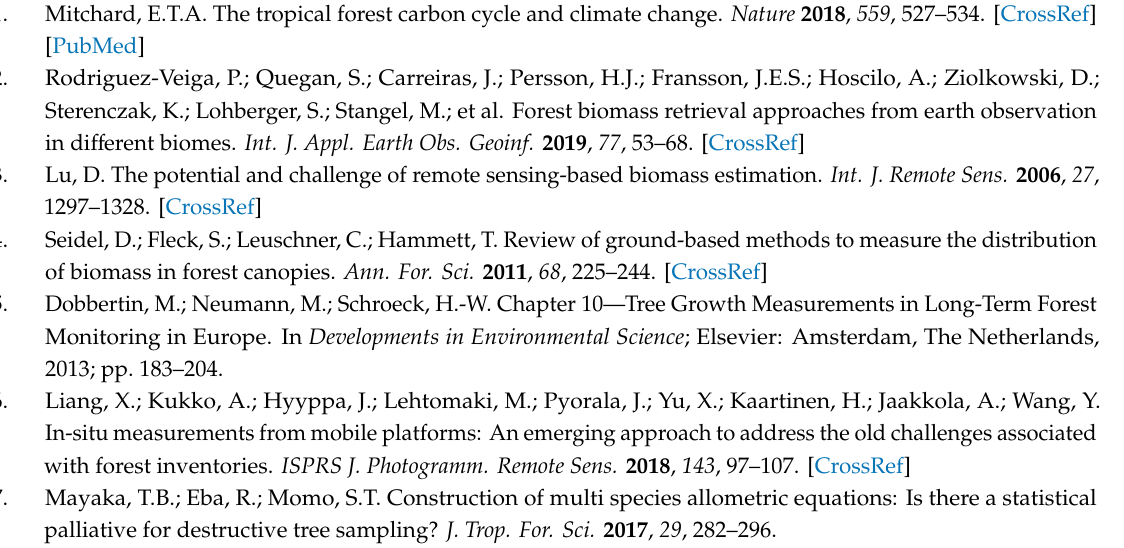
Figure S1. Simulated stands as a forest population for the model testing experiment. The stand number corresponds to the number in Table S1; Table S1. The simulated data set, based on two assumptions with even (0.59, t m − 3 ) and randomly distributed for constructing a pseudo stand population in a large region (10,000 stands, assuming Eucalyptus); Table S2. Measurements of volume and biomass in China. The data include both measured volume and biomasses of each tree organs for 261 species at 1607 field plots over the